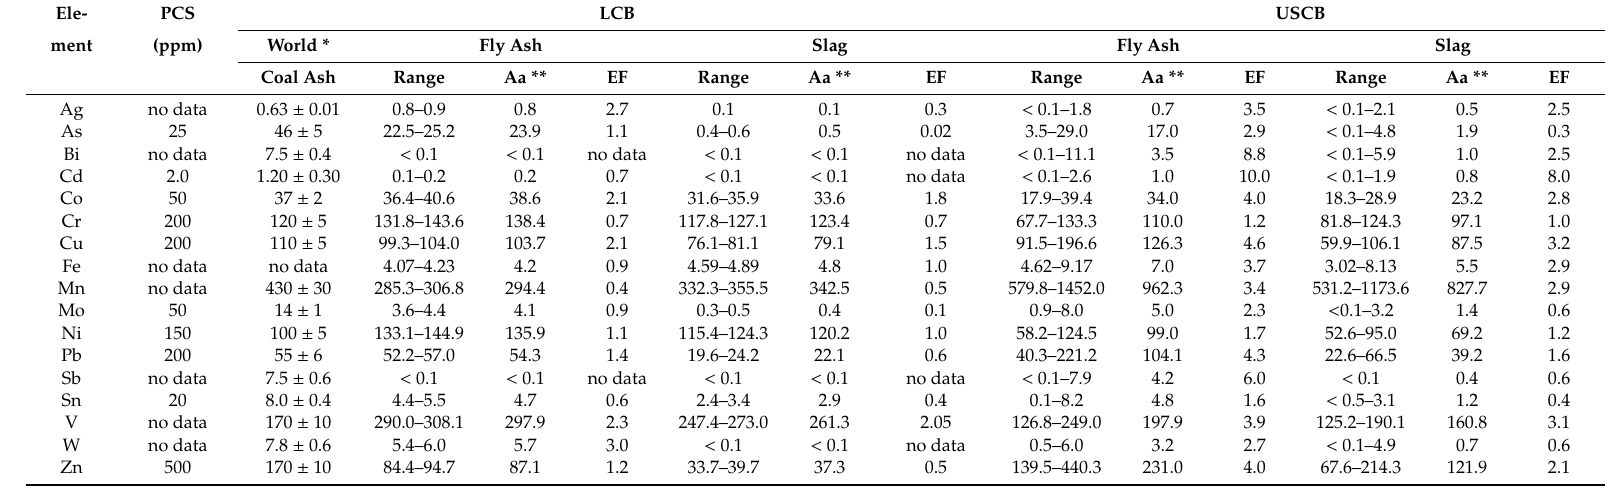
Table 5. Enrichment factor (EF) of elements in fly ash and slag relative to the content of elements in coal feeds from the LCB and the USCB, as well as allowable concentrations of elements in soil determined (in accordance with Polish Journal of Laws 2016 item 1395, 2016; [92]) for group I soils (PCS) and the content of elements in coal ash from world